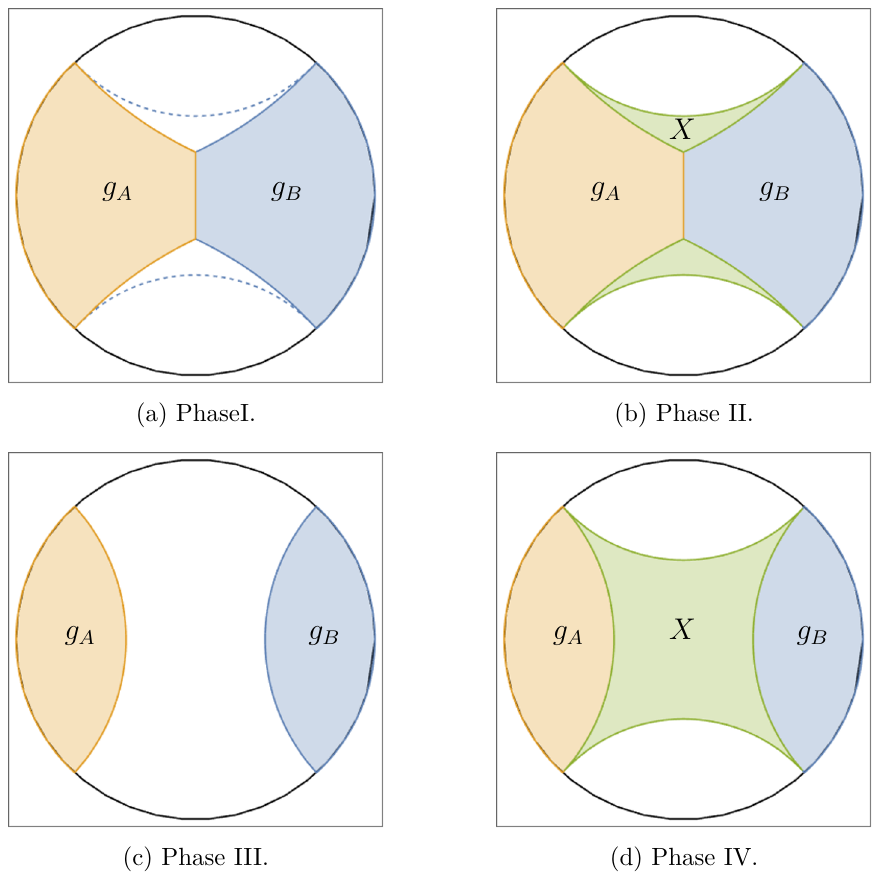
Figure 18 . Different phases that can dominate in the reflected entropy bulk